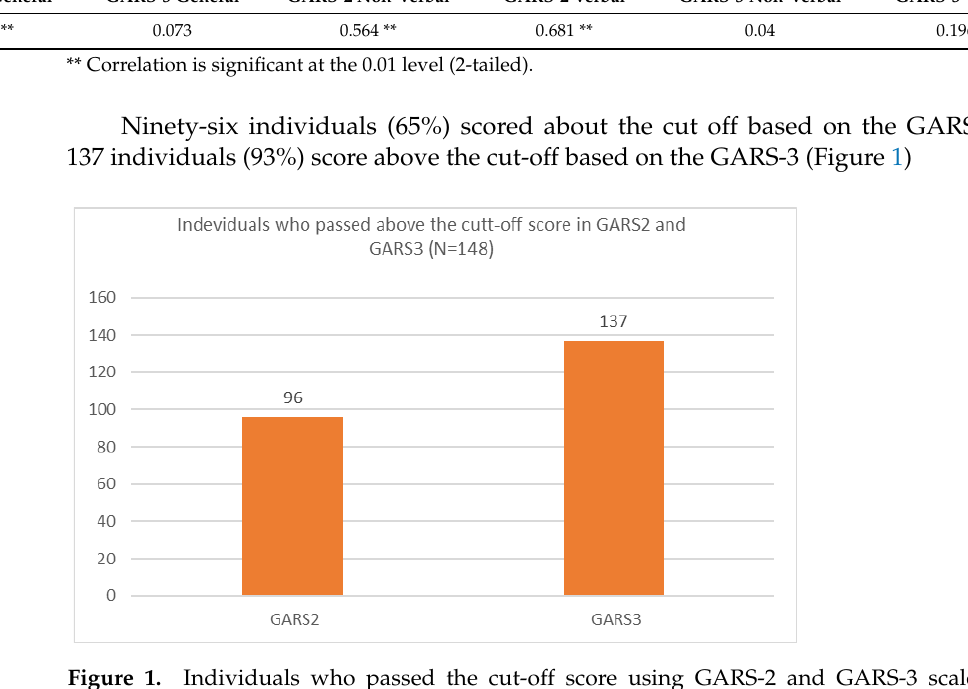
Comparison of percentage of cases who pass cut-off scours based on GARS2 and GARS3 in the present study and two previous others Figure 2. Comparison of the groups who passed the cut-off scours of GARS-2 and GARS-3 in the present study and two previous others. The analysis also indicated a significant difference between the screening score for ASD and the non-ASD group, and individuals with ASD had a significantly higher score (X 2 = 77.1, df = 1, p = 0.000). Respondents were 84 couples (57%), while only two respond- ents (1.4%) were non-parents (siblings). A majority of the sample (64, 43%) were firstborn. One hundred and thirty-nine (89%) individuals were from Erbil city, and the rest were from the other neighboring towns. Sixty-three percent (93 members) became concerned about their children before the second year of their caretakers or earlier. There was also a significant difference between male and female individuals being diagnosed with GARS-2 (X 2 = 3.63, df = 1, p = 0.046), and female individuals had signifi- 92%